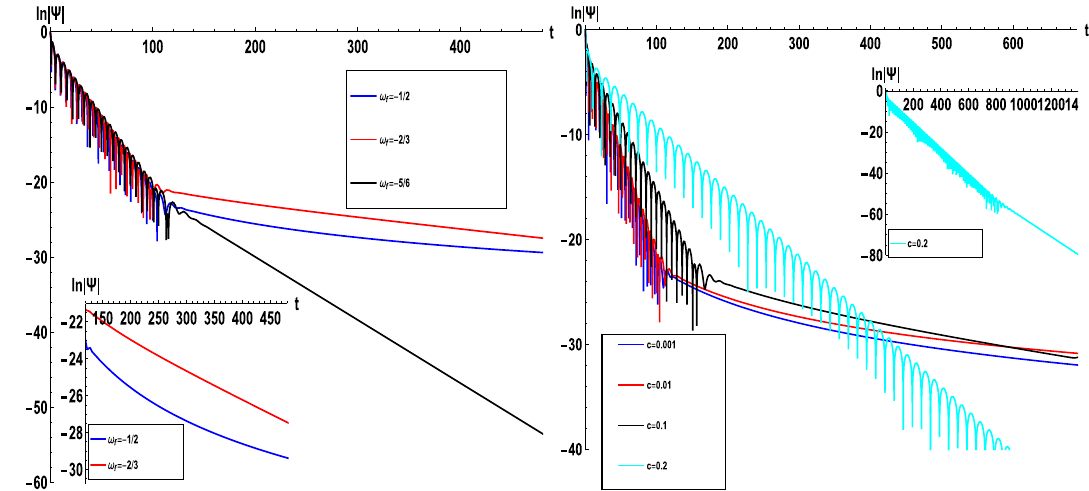
Fig. 2 Late-time behavior of propagating scalar field in dirty black holes, profiles of exponential decay or power-law tail. Left panel: M = 2 Q = l = 10 c = 1; right panel: M = 2 Q = l = − 2 ω f =